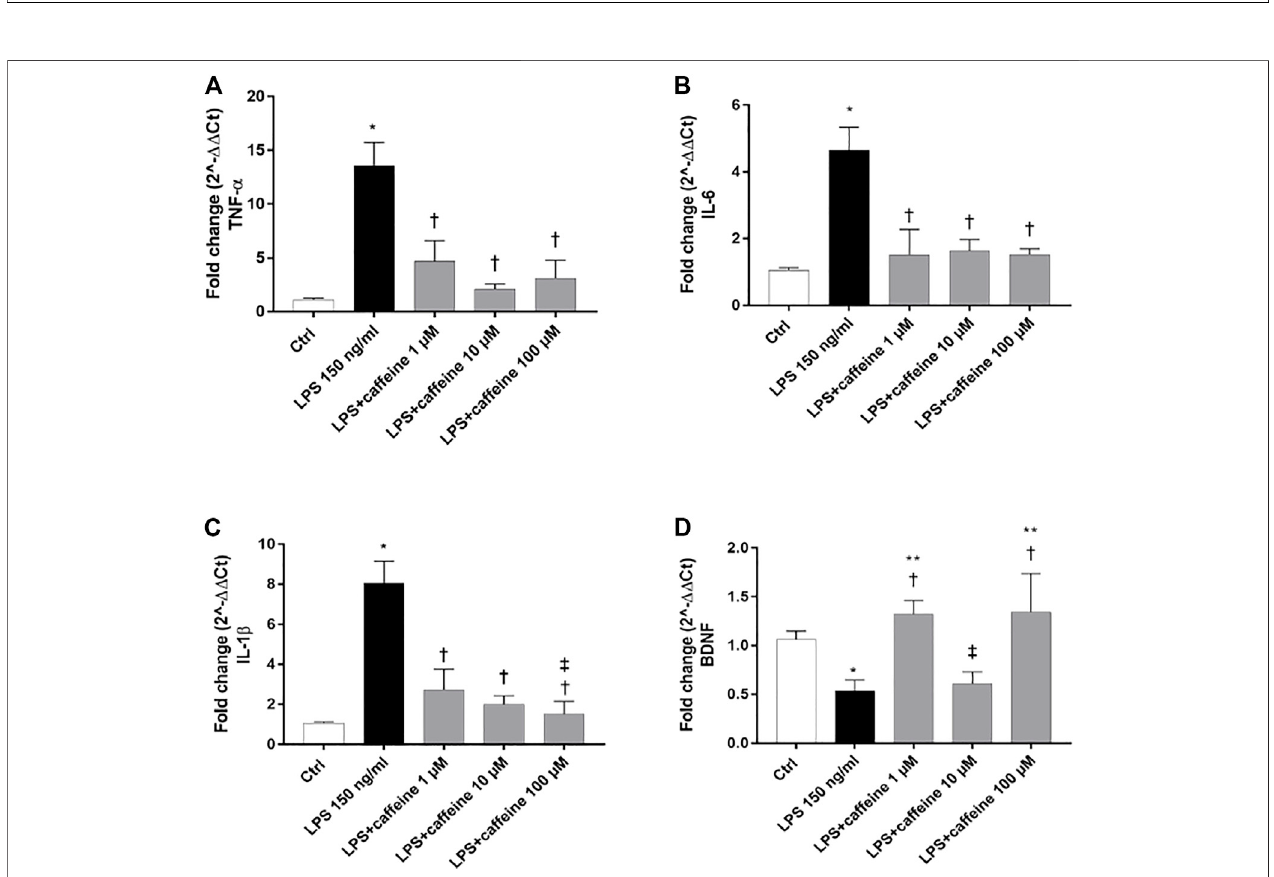
FIGURE 2 | Caffeine counteracts in fl ammation and elicits the BDNF expression after LPS treatment. ARPE-19 were pretreated with caffeine (1 – 10 – 100 µM) for 24 h and then co-treated with LPS (150 ng/ml) for 2 h. Caffeine downregulated TNF- α (A) , IL-6, (B) and IL-1 β (C) mRNA levels, up-regulated by the LPS challenge. Caffeine1and 100 µM increasedBDNF mRNA levels, reducedbyLPS (D) .Values werereportedasmean ± SD; n (cid:1) 4.Datawereanalyzedbyone-wayANOVA and the Tukey post hoc test for multiple comparisons. * p < 0.05 vs. control; † p < 0.05 vs. LPS 150 ng/ml; ‡ p < 0.05 vs. LPS + caffeine 1 μ M; ** p < 0.05 vs. LPS + caffeine 10